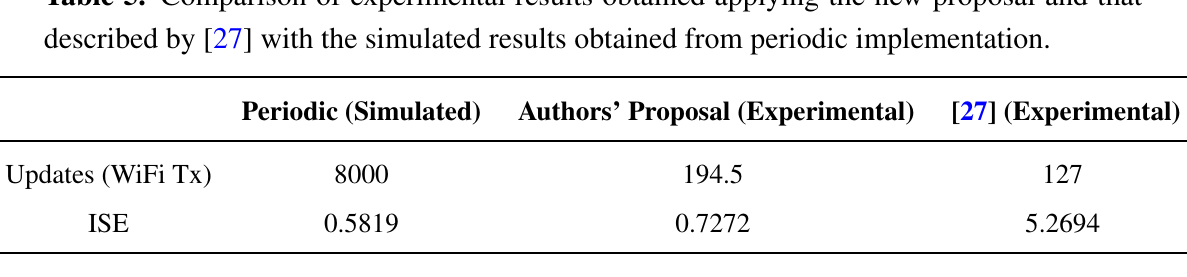
Table 5. Comparison of experimental results obtained applying the new proposal and that described by [27] with the simulated results obtained from periodic